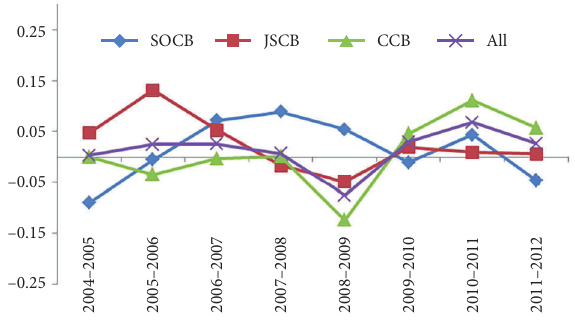
Figure 4. MPGGI change: 2004–2012